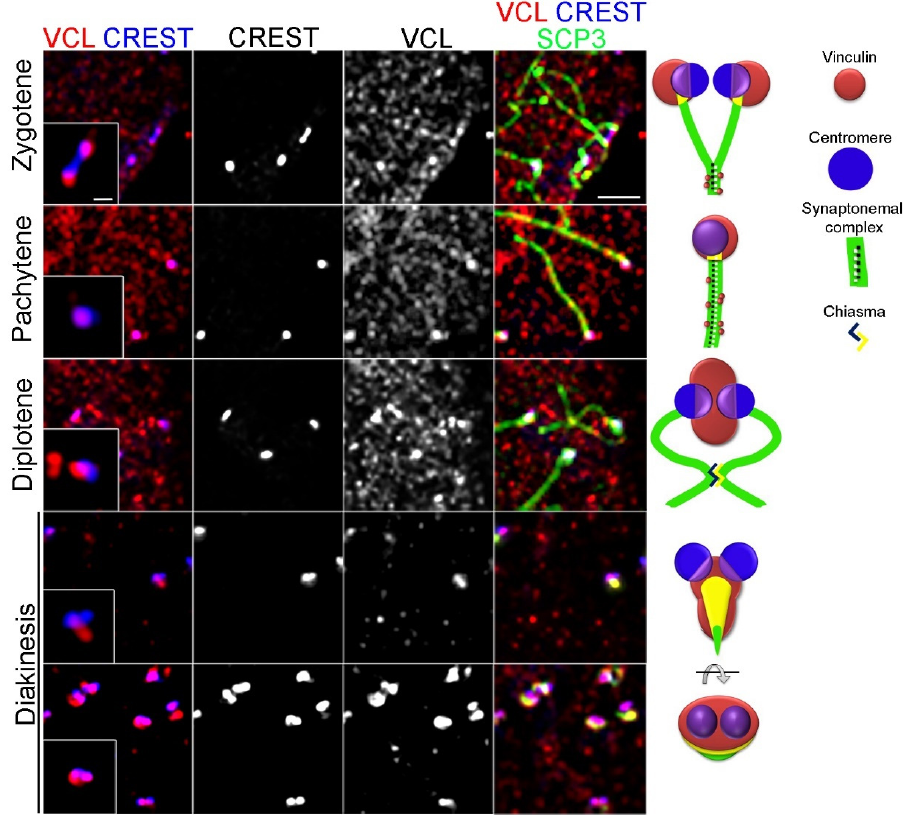
Figure 3. Co-localization of VCL and CREST-labeling centromeres on squashed spermatocytes. Immunofluorescence. VCL (red), CREST (blue), and SCP3 (green) were immunodetected in the primary spermatocytes. The meiotic stage was specified according to the state of chromosome pairing, i.e., pattern of SCP3. We found diverse VCL morphology regarding prophase I progression, associated with centromeres. We analyzed more than 100 squashed spermatocytes of each prophase I stage. The panel to the right depicts a localization pattern and represents the most observed conditions in each stage. The scale bar corresponds to 10 µ m. The scale bar in the inset corresponds to 2 µ